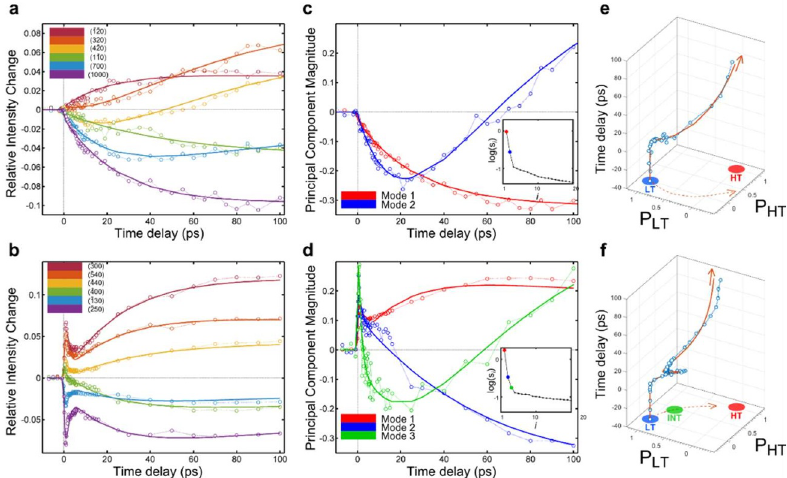
Fig. 2 . Comparison of UED results for both (EDO-TTF) 2 XF 6 derivatives, top panels for X = Sb and bottom panels for X = P. The left panels show relative change in the intensity of select diffraction spots. The middle panels show the results of the SVD analysis, wherein the thin lines are the major right-singular vectors, the thick lines are global exponential fits, and the insets are logarithmic plots of the singular values. The right panels are trajectories in Pearson correlation space